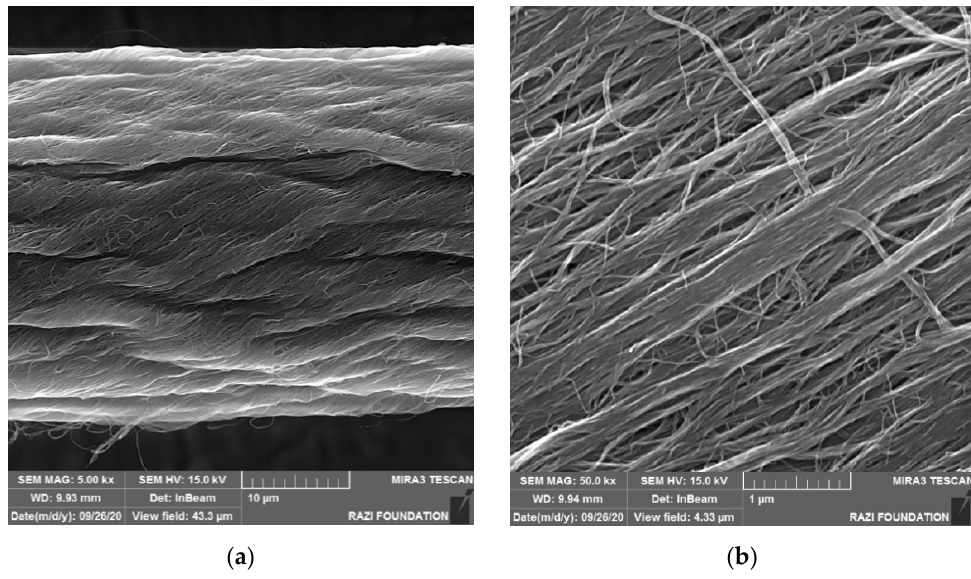
Figure 1. Scanning Electron Microscopy (SEM) images of CNTY: ( a ) 5000 × ; ( b ) 50,000 × . Table 1. Description and physical properties of polymeric matrices [16,17].